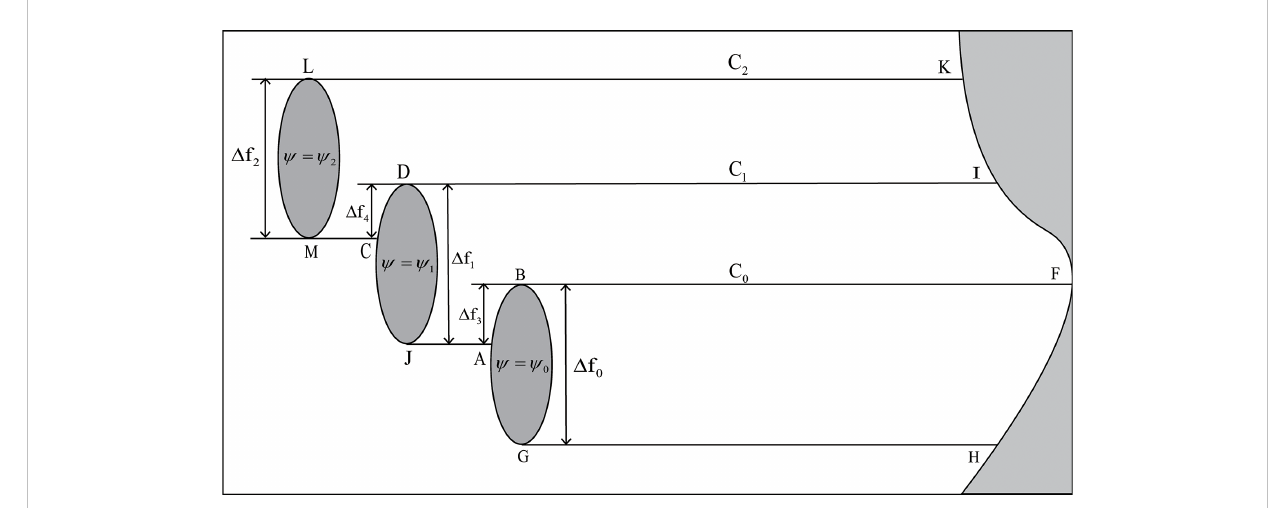
FIGURE 5 As in Figure 2 but for Case